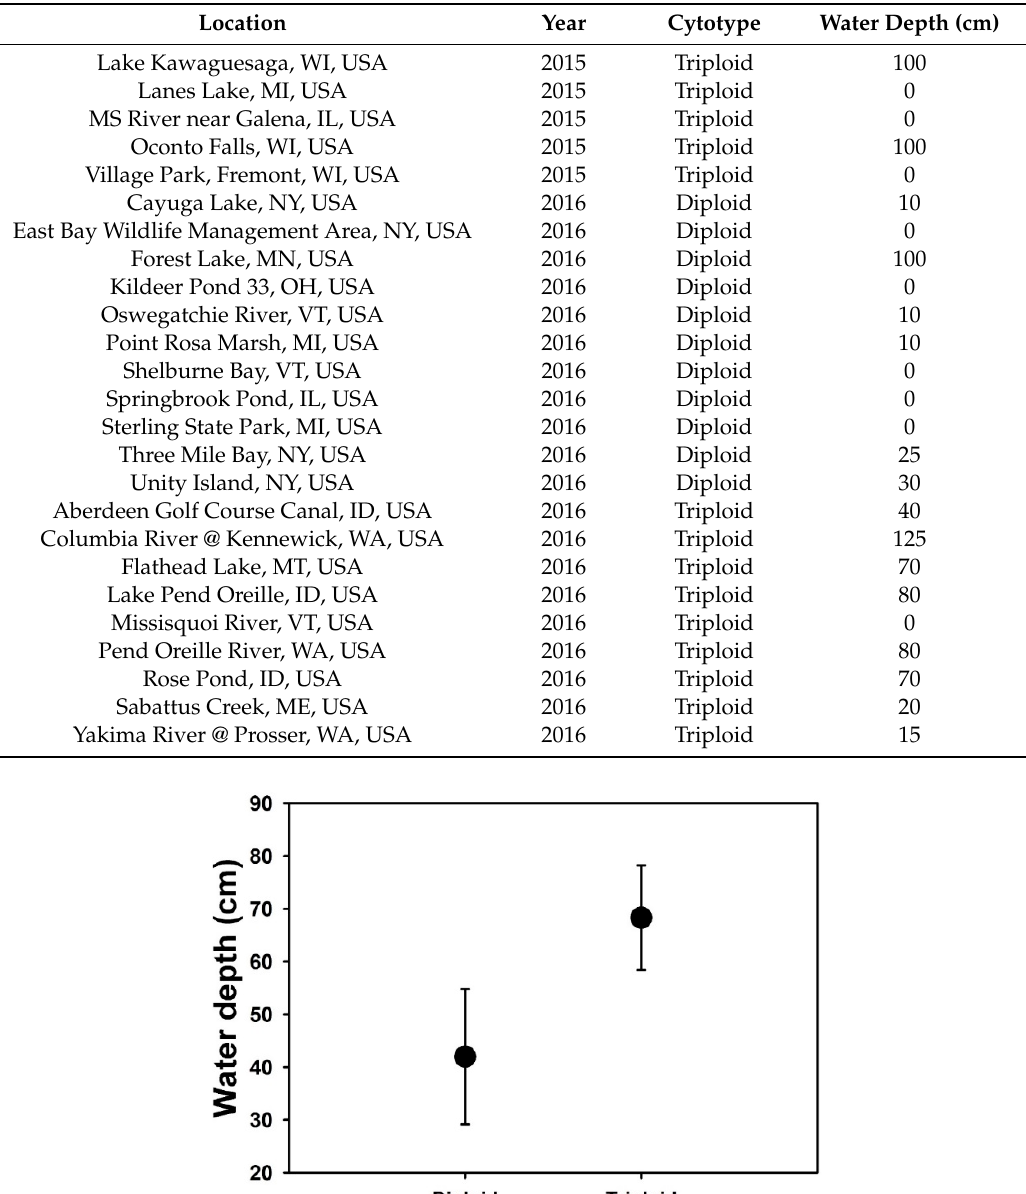
Figure A1. Mean ( ± SE) water depth recorded for diploid and triploid populations of B. umbellatus at field sites from 2014 to 2016.